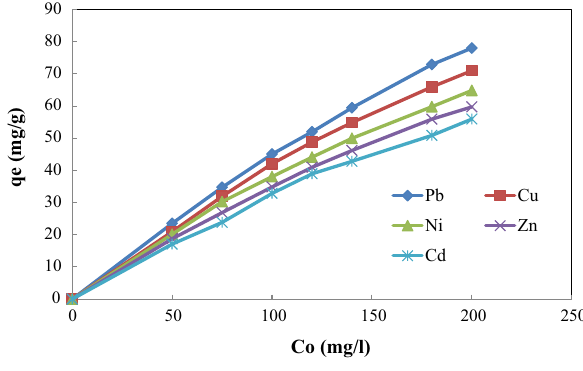
Fig. 6 Effect of the initial concentration of heavy metals on the